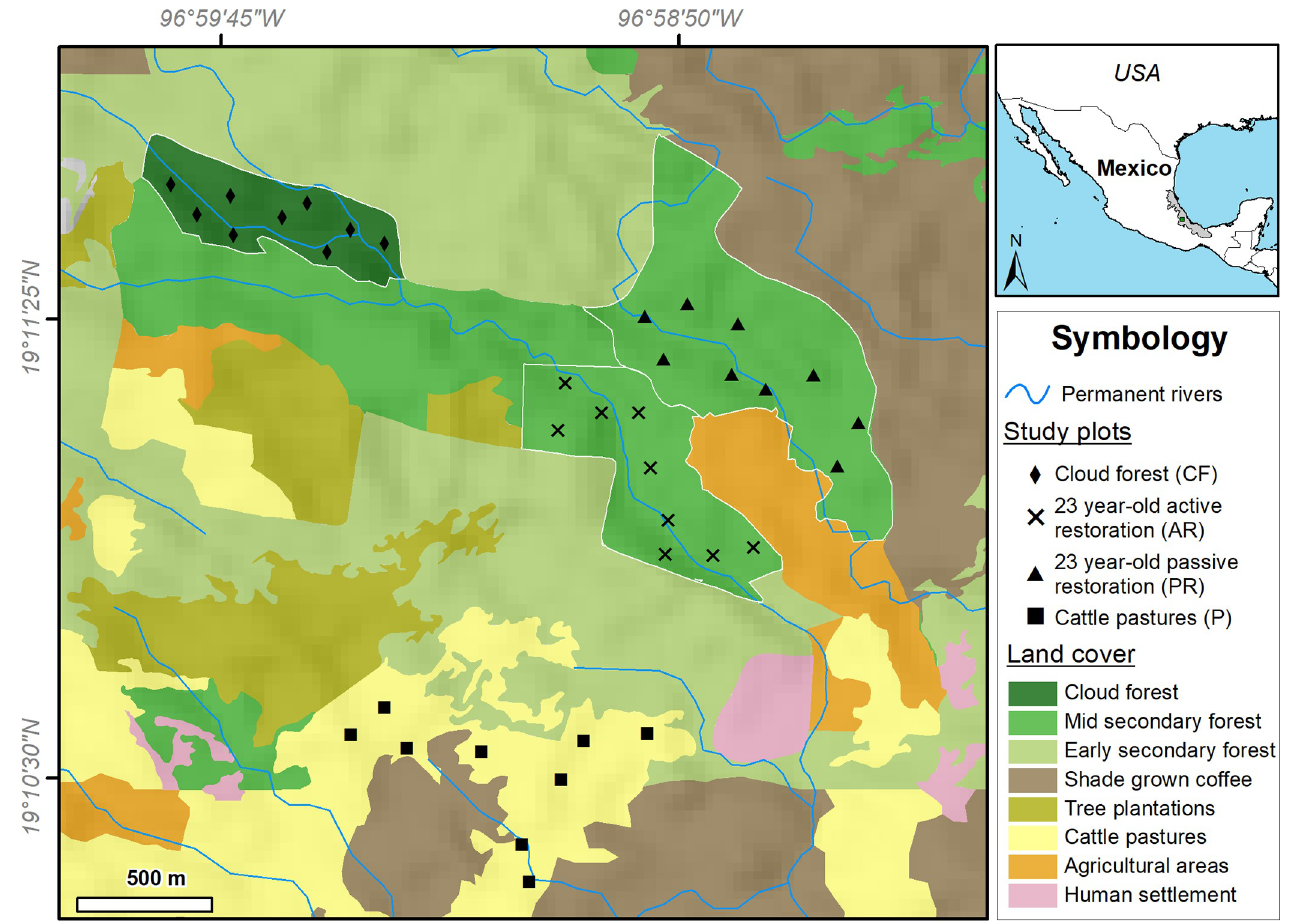
Fig 1. Map showing the study area, land-cover types, and the location of 36 study plots (black markers) in four vegetation types studied in the mountainous region of central Veracruz, Mexico. Tree plantations include monocultures of bamboo, avocado and pine.